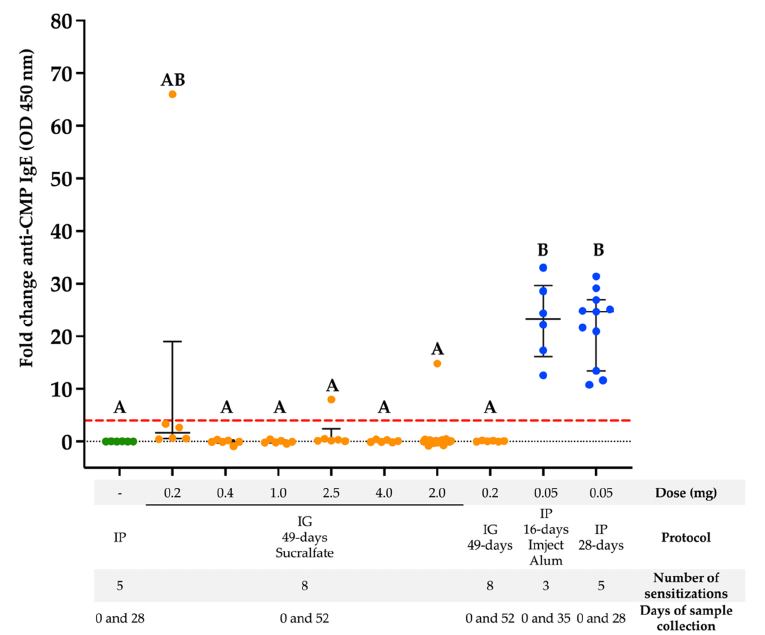
Figure 2. Comparison between the intragastric and IP routes of sensitization to CMP in BALB/c mice. The presence of anti-CMP IgE was evaluated using ELISA. Different letters represent a statis- tically significant difference ( p < 0.05). IG: intragastric; IP: intraperitoneal; CMP: cow´s milk proteins. Green dots: control group; Orange dots: IG protocol ( n = 6 or 24); Blue dots: IP protocol ( n = 6 or 11); Dotted line: 4-Fold change cut-off value.